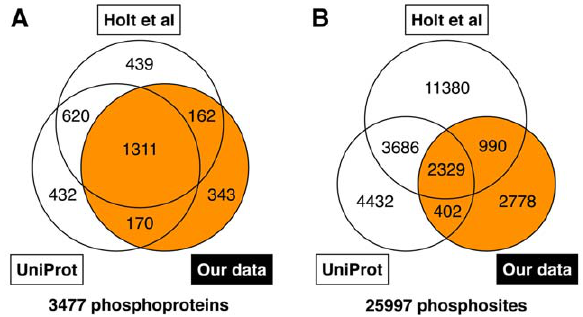
Figure 2. Number counts of phosphoproteins (A) and their phosphosites (B) newly identified in this study and of those obtained from the data of Holt et al. [ 16 ] and UniProt [ 19 ] .